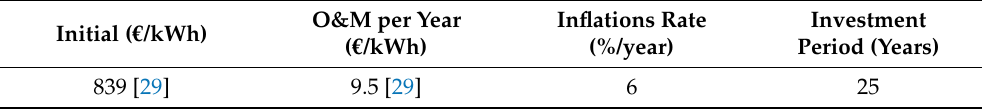
Table 2. Economic data of the study.